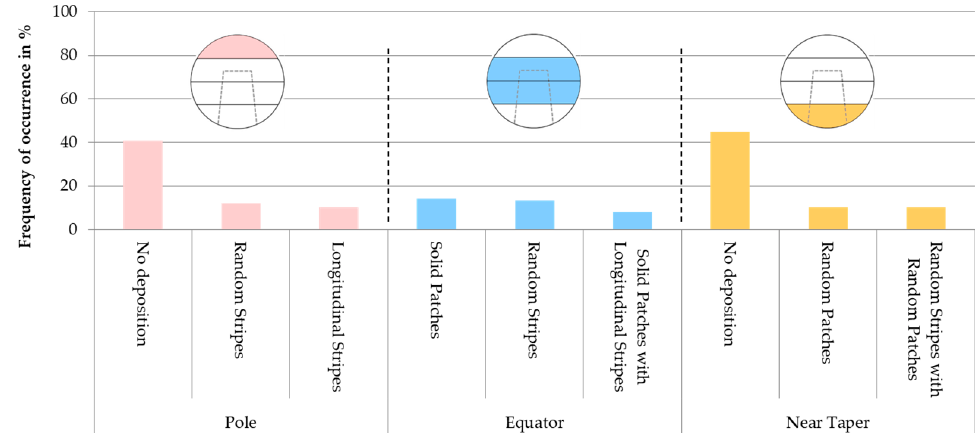
Figure 6. Most frequent deposition patterns on the femoral heads in the areas pole, equator and near taper.